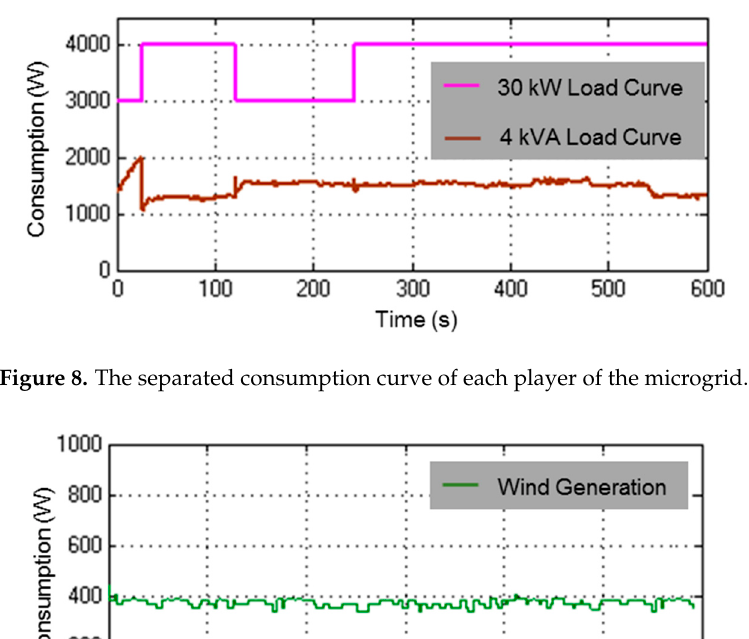
Figure 7. Real-time simulation of the consumption profile using the consumers of the microgrid.